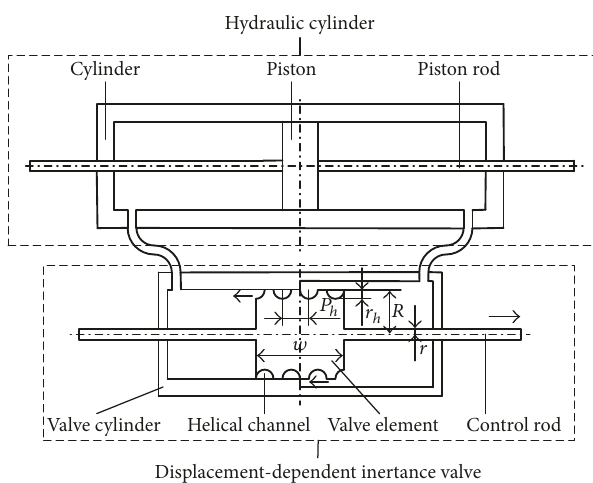
Figure 2: A continuously adjustable inerter device.